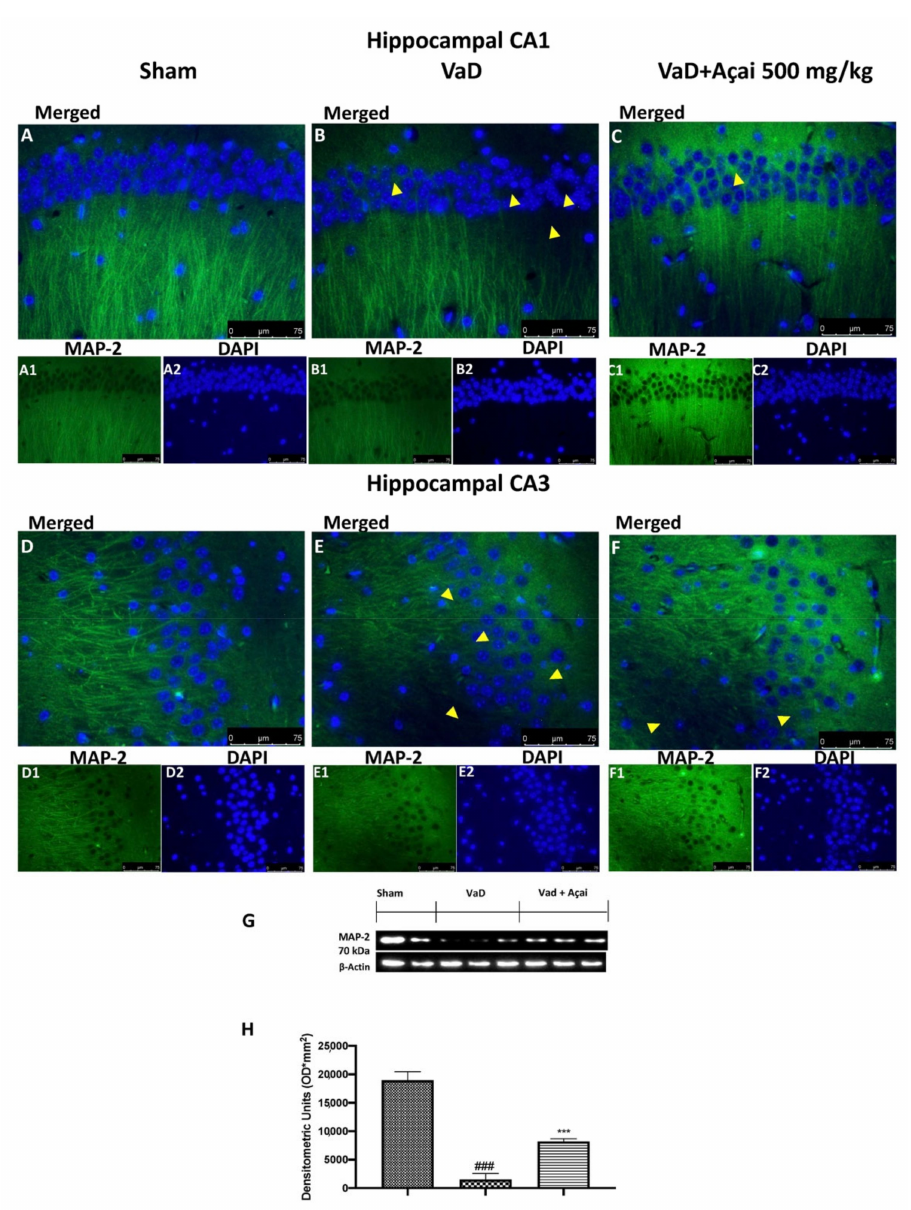
Figure 9. Açai berry mitigates MAP-2 alteration. Hippocampal CA1 figure of Sham ( A , A1 , A2 ), VaD ( B , B1 , B2 ), Açai Berry ( C , C1 , C2 ); Hippocampal CA3 figure of Sham ( D , D1 , D2 ), VaD ( E , E1 , E2 ), Açai Berry ( F , F1 , F2 ); MAP-2 western blot ( G ), and relative densitometric analysis ( H ) Arrows indicate the alteration or absence of MAP-2. Values are means ± SEM of 6 mice for all groups. Figures are representative from at least three experiments. See manuscript for further details. *** p < 0.001 vs. sham; ### p < 0.001 vs.